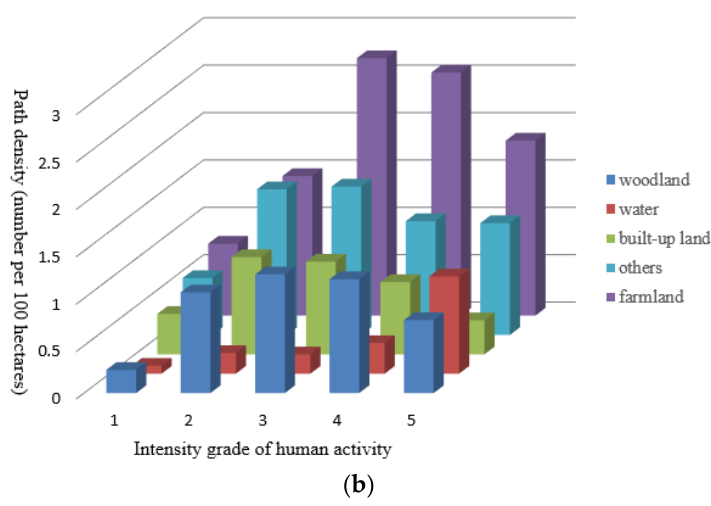
Figure 9. Change of patch density with human activity intensity at the class level: ( a ) 2009; ( b ) 2013.